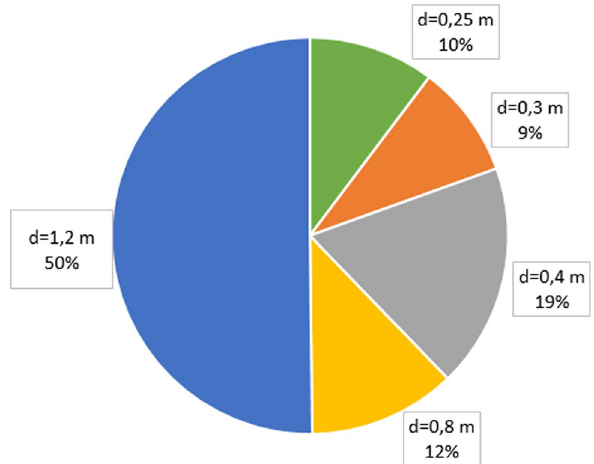
Fig. 2 Percentage of each pipe diameters in the total network